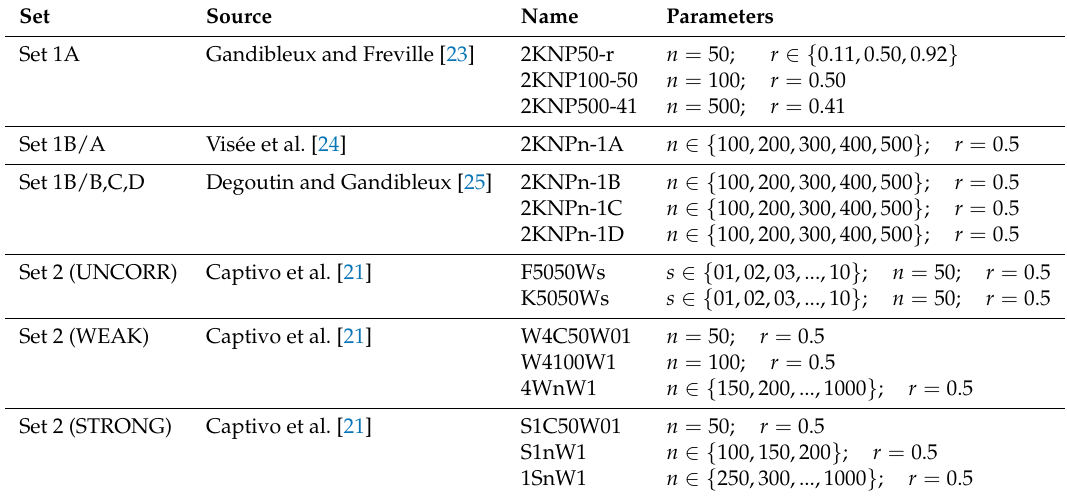
Table 1. Bi-objective KNP instances. The instance number ( s ), the number of items ( n ) and tightness ratio ( r ) refer to the parameters of the